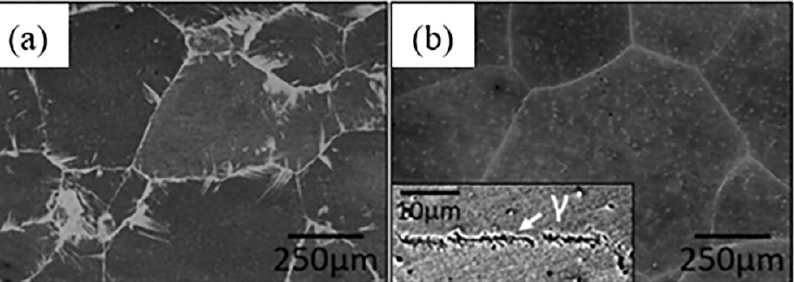
Figure 8. Optical micrographs of air-cooled sample after solution treatment at 1225 °C for 1 h: ( a ) Fe-34.0%Mn-16.5%Al-7.5%Ni (at. %); ( b ) Fe-34.0%Mn-15.0%Al-7.5%Ni-1.5%Ti (at. %) [89]. Reprinted with permission from Ref. [89]. Copyright 2017 Elsevier.